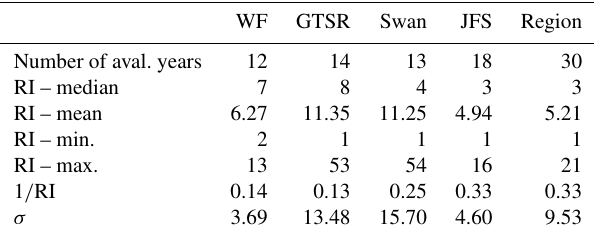
Table 4. Avalanche chronologies and return interval (RI) statistics of all four subregions; 1 / RI refers to the probability of an avalanche occurring in that avalanche path in any given year, and σ refers to the standard deviation of the RI. WF GTSR Swan JFS Region Number of aval. years